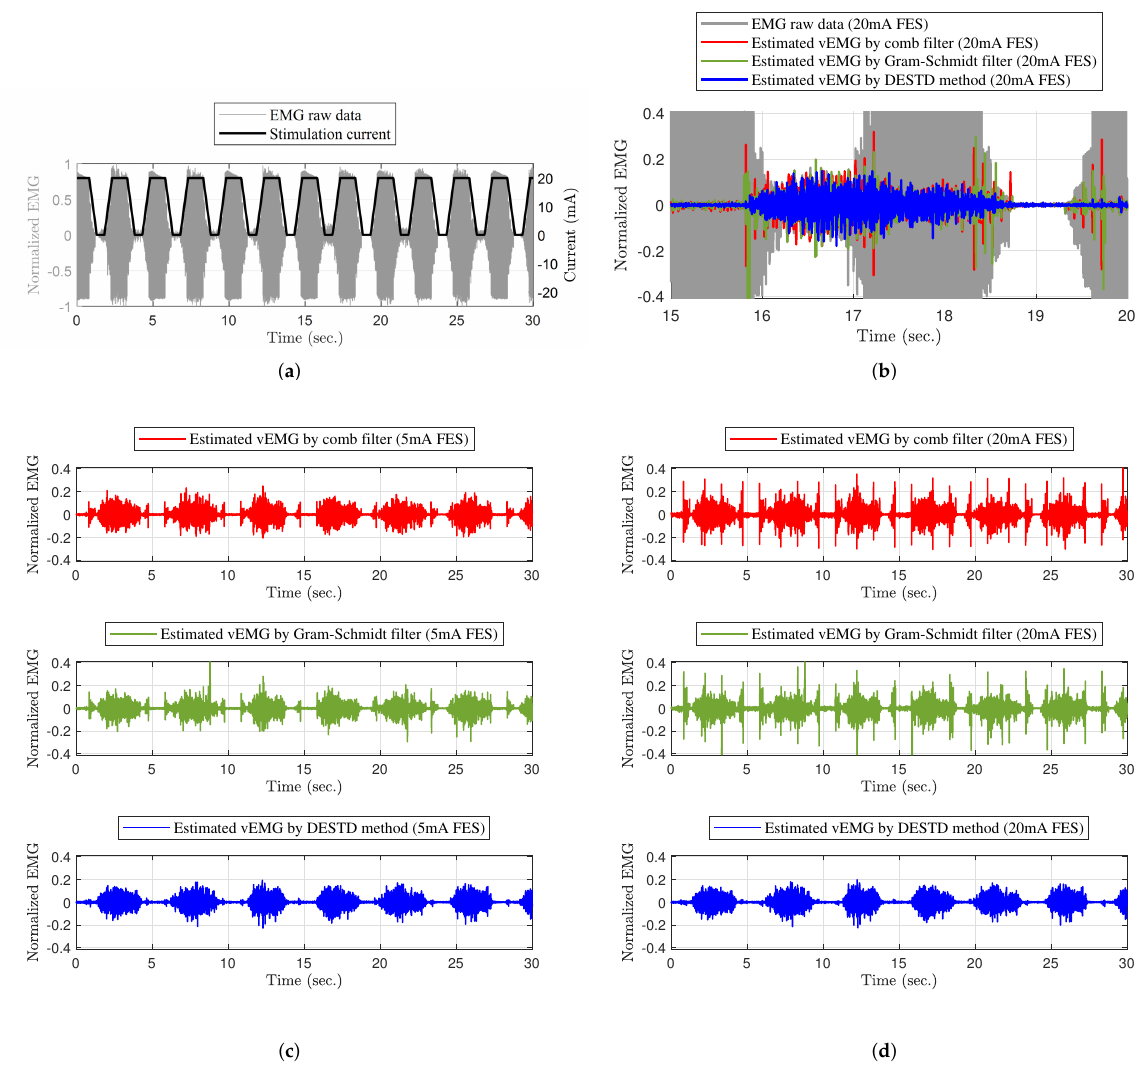
Figure 7. Example of EMG experimental results: ( a ) stimulation current and EMG raw data without filters, ( b ) vEMG comparison of experimental results over 15 to 20s, vEMG data filtered by filters with maximum ( c ) 5mA, and ( d ) 20mA stimulation current of dynamically modulating